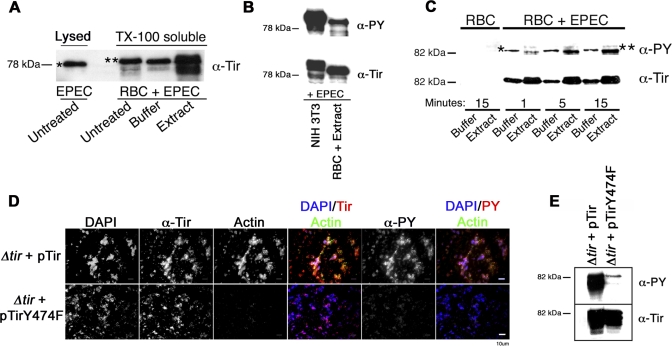
EPEC Tir Undergoes Modification in RBC Membranes and Is Rapidly Phosphorylated on Y474 upon Exposure to Extract(A) Western analysis using anti-Tir antibody of lysed EPEC (lane 1) or the TX-100 soluble fractions of RBC infected with EPEC and left untreated (lane 2), or treated with buffer or extract for 30 min (lanes 3 and 4). Note that the molecular weight of Tir increases from 78 kDa (*) (untranslocated Tir) to ∼82 kDa (**) upon infection of RBC, regardless of any post-infection treatment. Also note the increase in the amount of Tir in the TX-100 soluble fraction of infected RBC exposed to extract.(B) Western analysis using anti-Tir antibody and anti-PY 4G10 antibody of the TX-100 soluble fraction of 3T3 cells infected with EPEC (lane1), or RBC infected with EPEC and exposed to extract for 20 min (lane 2). Note that Tir from RBC infected with EPEC and exposed to extract is tyrosine phosphorylated, but does not undergo the same shift in molecular weight seen in infected 3T3 cells.(C) Western analysis using anti-Tir antibody and anti-PY 4G10 antibody in the TX-100 soluble fraction of either uninfected (lanes 1 and 2) or infected (lanes 3–8) RBC exposed to extract or buffer for 1, 5, or 15 min. Note that Tir is rapidly phosphorylated on the 82 kDa species after exposure to extract (**). A tyrosine phosphorylated protein of approximately the same molecular weight as Tir was evident following infection of RBC and exposure to buffer (*), but further analysis determined that this phosphoprotein was not Tir.(D) Images of RBC infected with EPECΔtir mutants overexpressing either WT Tir (Δtir + pTir ) or Y474F Tir (Δtir + pTirY474F) and exposed to extract for 20 min. Cells are labeled with DAPI to identify EPEC, Alexa-488-phalloidin to visualize actin, and either anti-Tir antibody or anti-PY 4G10 antibody. Note the lack of actin polymerization and PY staining in RBC infected with EPECΔtir + pTirY474F. Scale bars represent 10 μm.(E) Western analysis using anti-Tir antibody and anti-PY 4G10 antibody of the TX-100 soluble fraction of RBC infected with EPECΔtir + pTir or EPECΔtir + pTirY474F and exposed to extract. Note that no phosphorylation of Tir is evident in RBC infected with EPEC Δtir + pTirY474F.